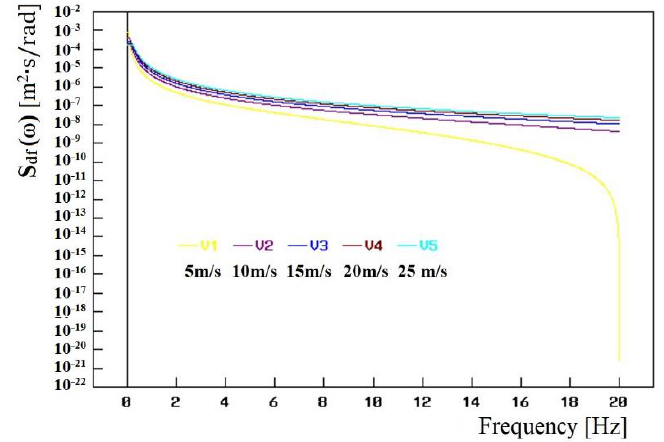
Figure 9. Power spectral density of the excitation S df ( ω ) for road C (average) and five vehicle speed values v: 5 m/s, 10 m/s, 15 m/s, 20 m/s, and 25 m/s.